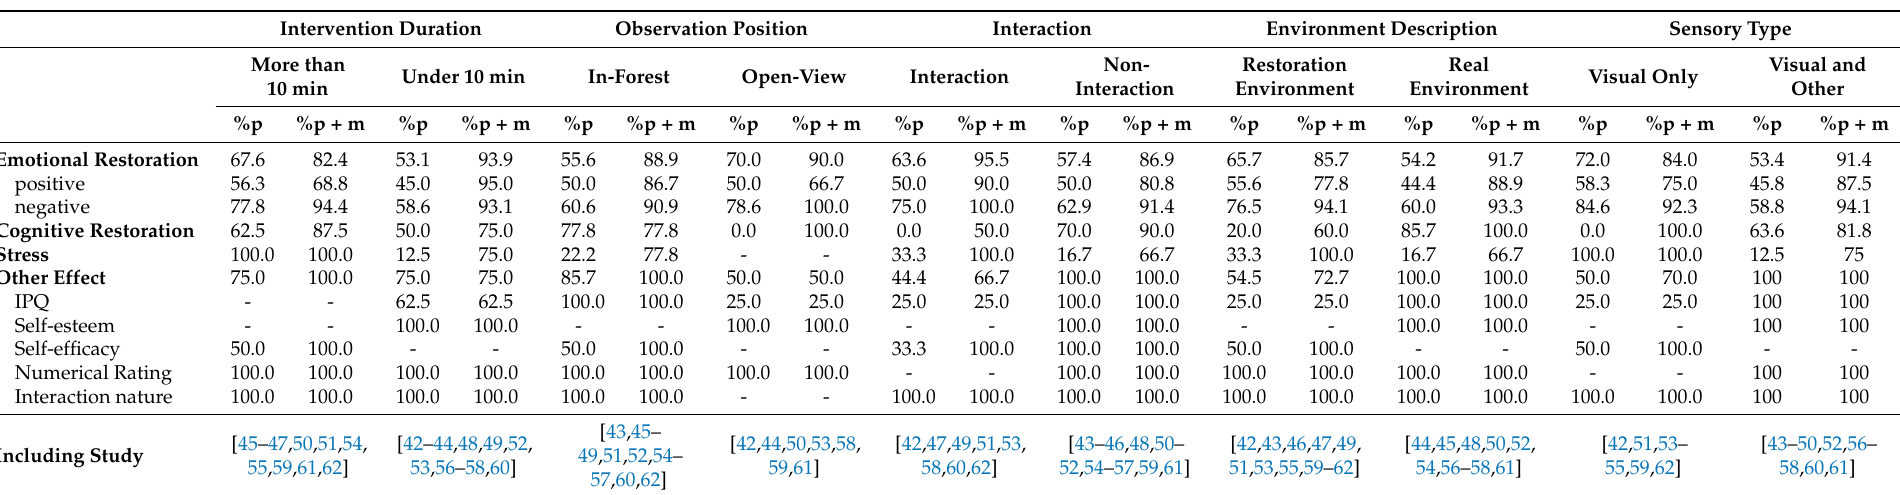
Table 4. Outcomes according to the intervention type conducted in the included studies. Intervention Duration Observation Position Interaction Environment